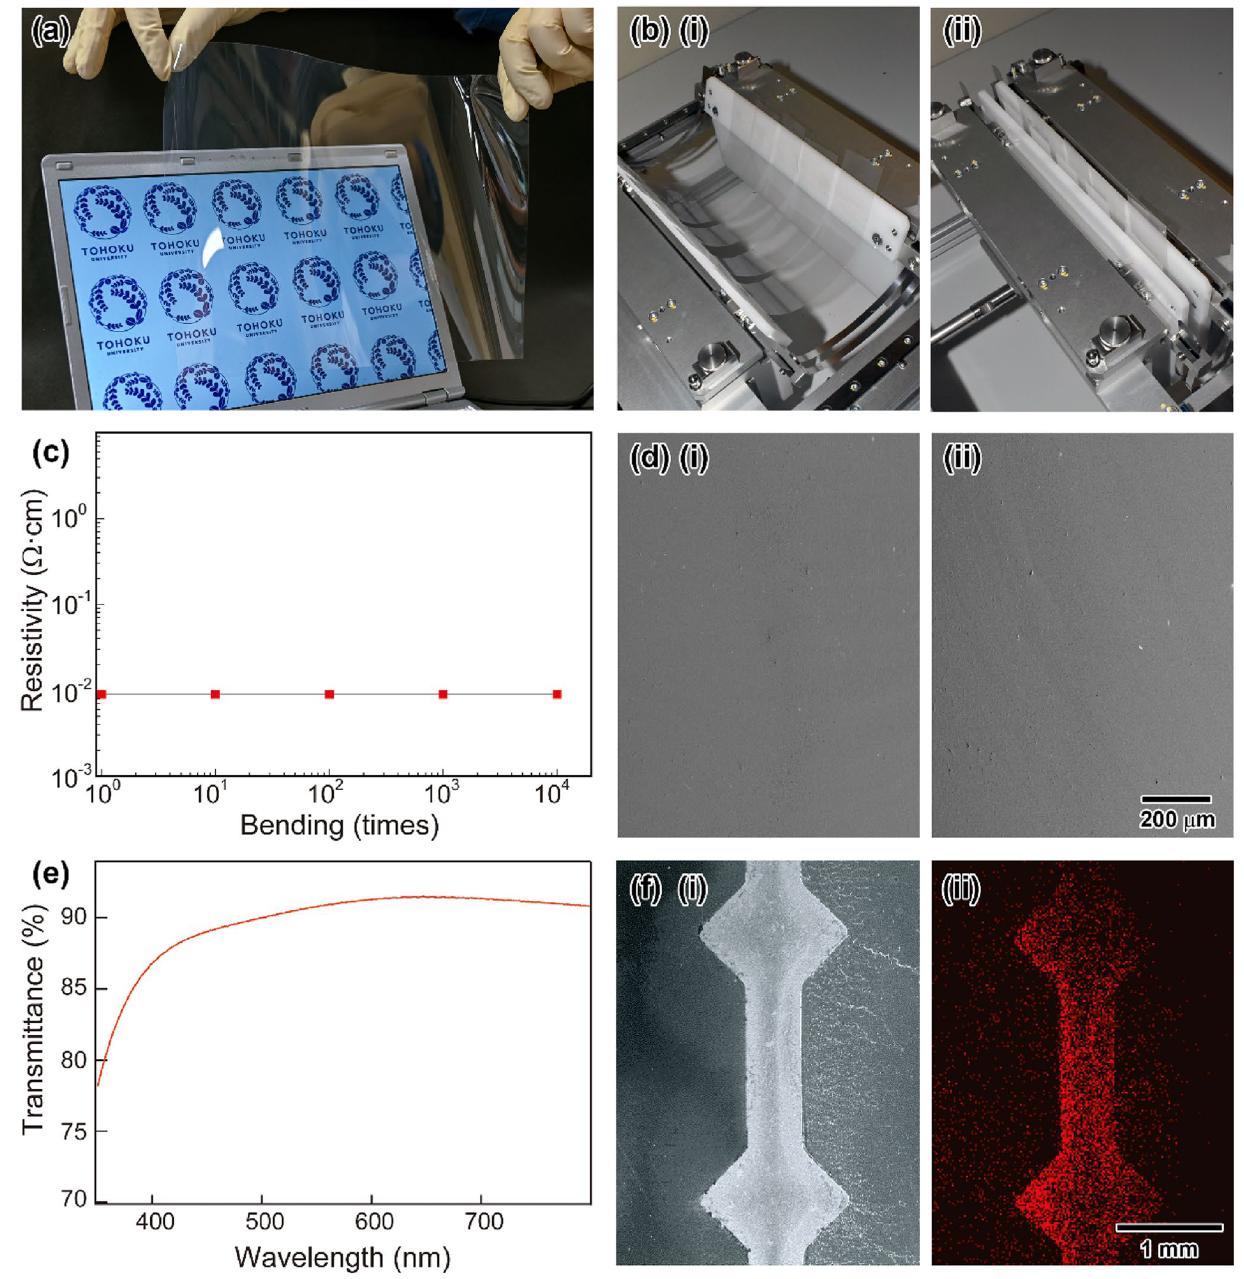
Figure 7. ( a ) Appearance of an ITO thin film (ca. 300 nm) on a PEN substrate (Q51-50, TOYOBO Co., Ltd., t = 50 μm) deposited by the NP-mist deposition method using P1 . ( b ) Photos of the ITO thin films on PEN substrates (i) before and (ii) after bending. ( c ) Change in the resistivity with bending. ( d ) SEM images of the P1 - based ITO thin films (i) before and (ii) after bending 10,000 times. The scale bar shown in (ii) is common to (i). ( e ) Transmittance spectra of the P1 -based ITO thin film on a PEN substrate prepared by the NP-mist deposition method (background: the corresponding PEN film). ( f ) (i) SEM image and (ii) corresponding EDS mapping image of In ions for the P1 -based thin film on a PEN substrate. The scale bar shown in (ii) is common to